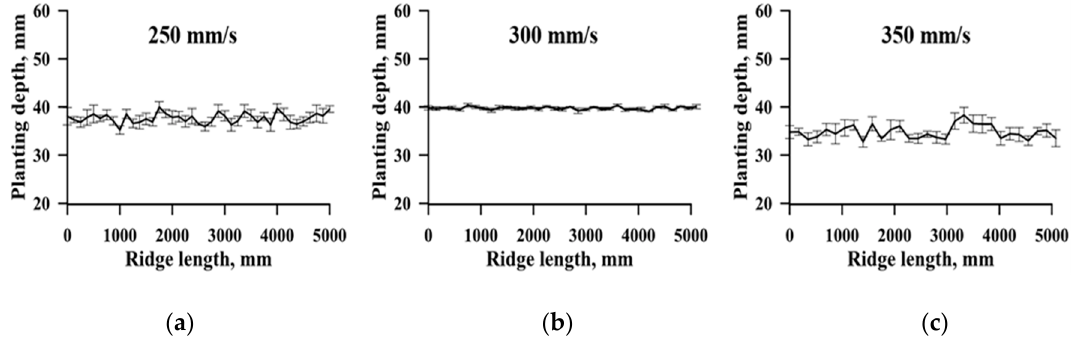
Figure 7. Planting depth uniformity during transplanting operations for transplanter forward speed levels of 250 ( a ), 300 ( b ), and 350 mm/s ( c ).